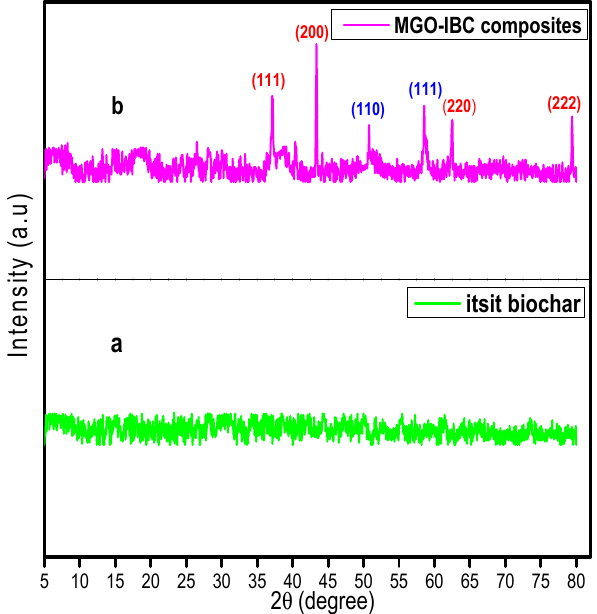
Figure 2. XRD spectrum of ( a ) IBC and ( b ) MgO-IBC composite.